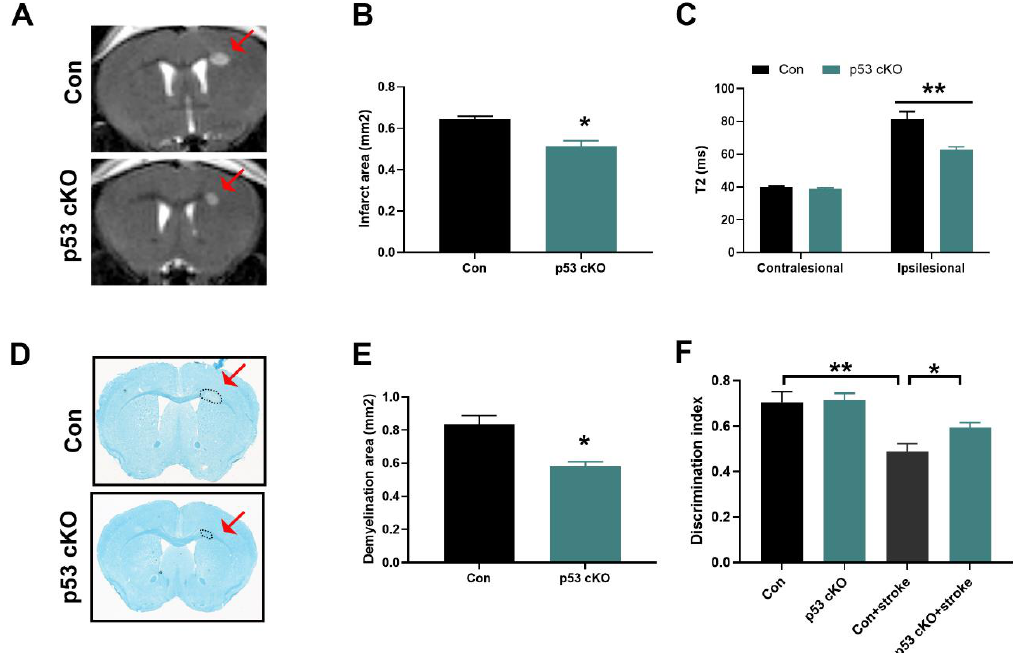
Figure 4. OL-specific loss of p53 function reduced brain injury and functional deficits after white matter stroke. ( A ). Representative T2-weighted MRI 3 days post stroke. ( B ). Quantitative graphs of T2-weighted MRI showed a significantly smaller lesion size in p53 cKO mice compared with Con mice. ( C ). Quantitative graphs of T2 relaxation time showed reduced edema in p53 cKO mice compared with Con mice. ( D , E ). Luxol fast blue (LFB) analysis showed reduced ischemic demyelination lesions in p53 cKO mice after 7 days compared to control mice. Dashed lines demarcate lesion areas. ( F ). p53 cKO mice showed a higher discrimination index than Con mice after white matter stroke in novel object recognition test. ( B , C , F ): n = 6 mice/group, two-tailed unpaired Student’s t -test for ( B , C ), one-way ANOVA test for ( F ); ( D ): n = 3 mice/group, two-tailed unpaired Student’s t -test. The data are presented as mean ± sem. The data are presented as mean ± sem. * p < 0.05, ** p < 0.01. ( A,D ): Red arrow and dotted lines demarcate lesion areas.